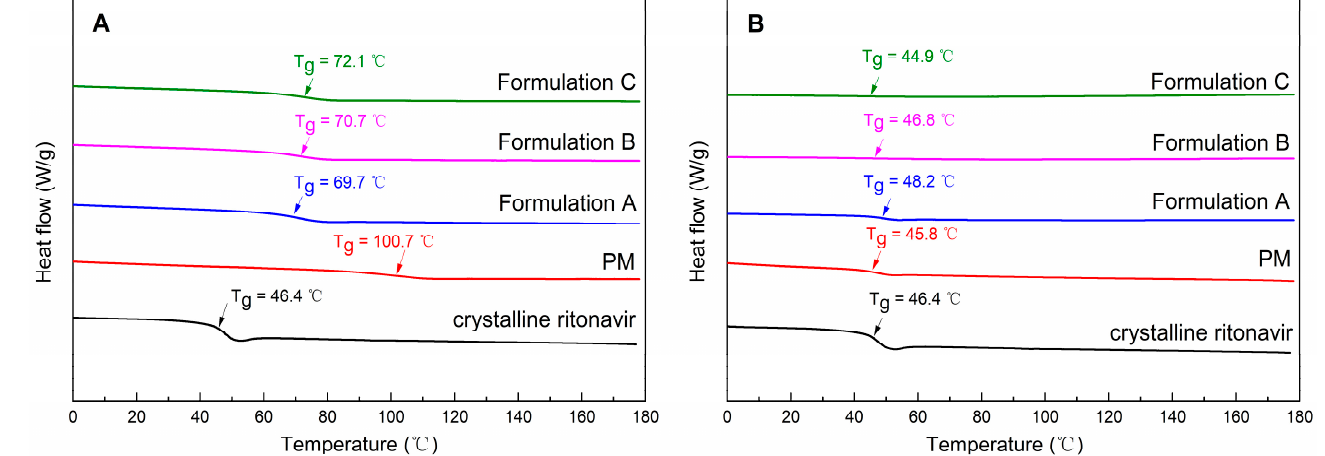
Figure 6. The glass transition temperature of milled extrudates ( A ) and precipitates ( B ). (PM: physical mixture of ritonavir/PVPVA/Span 20).